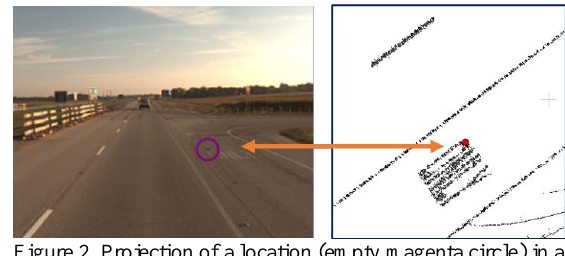
Figure 2. Projection of a location (empty magenta circle) in a RGB imagery onto the corresponding LiDAR Point cloud (red dot) using the estimated LiDAR/camera/GNSS/IMU system calibration parameters